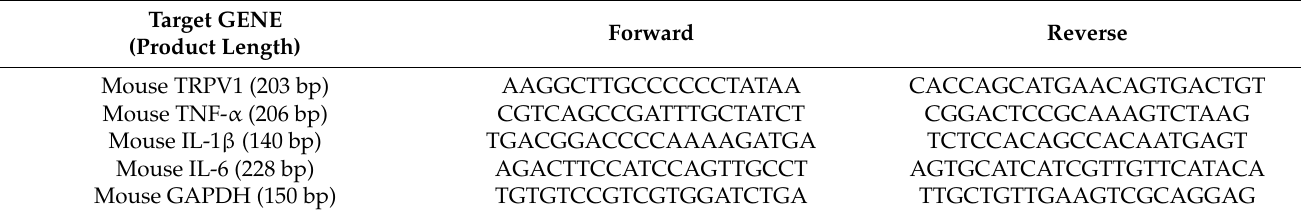
Table 1. Primers used for RT-qPCR